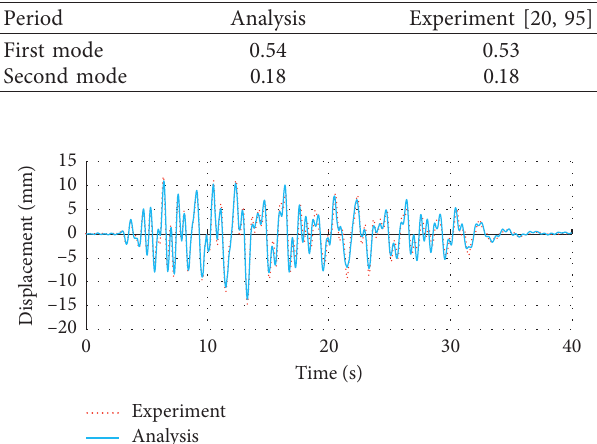
Figure 5: History lateral displacements of the first storey obtained from analysis and experiment [20, 95].